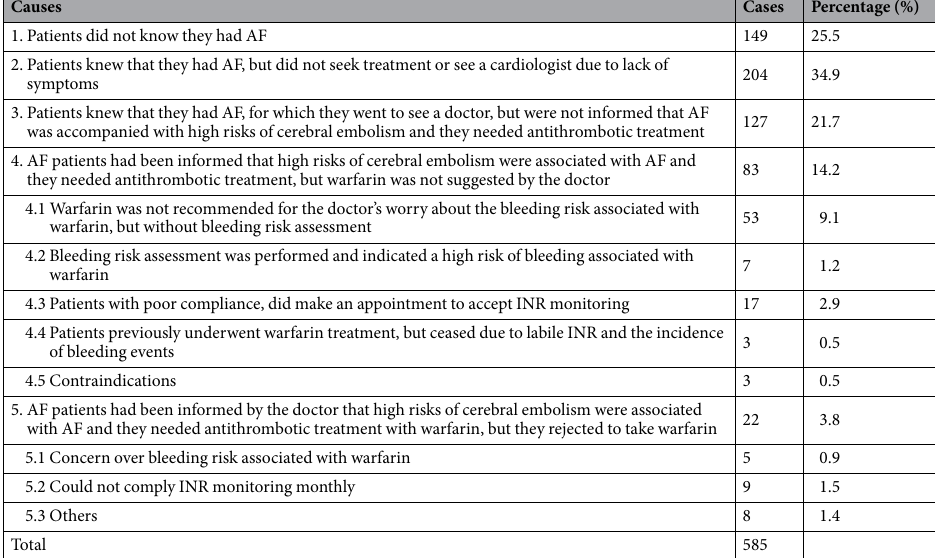
Table 1. Causes on the failure of warfarin usage in atrial fibrillation